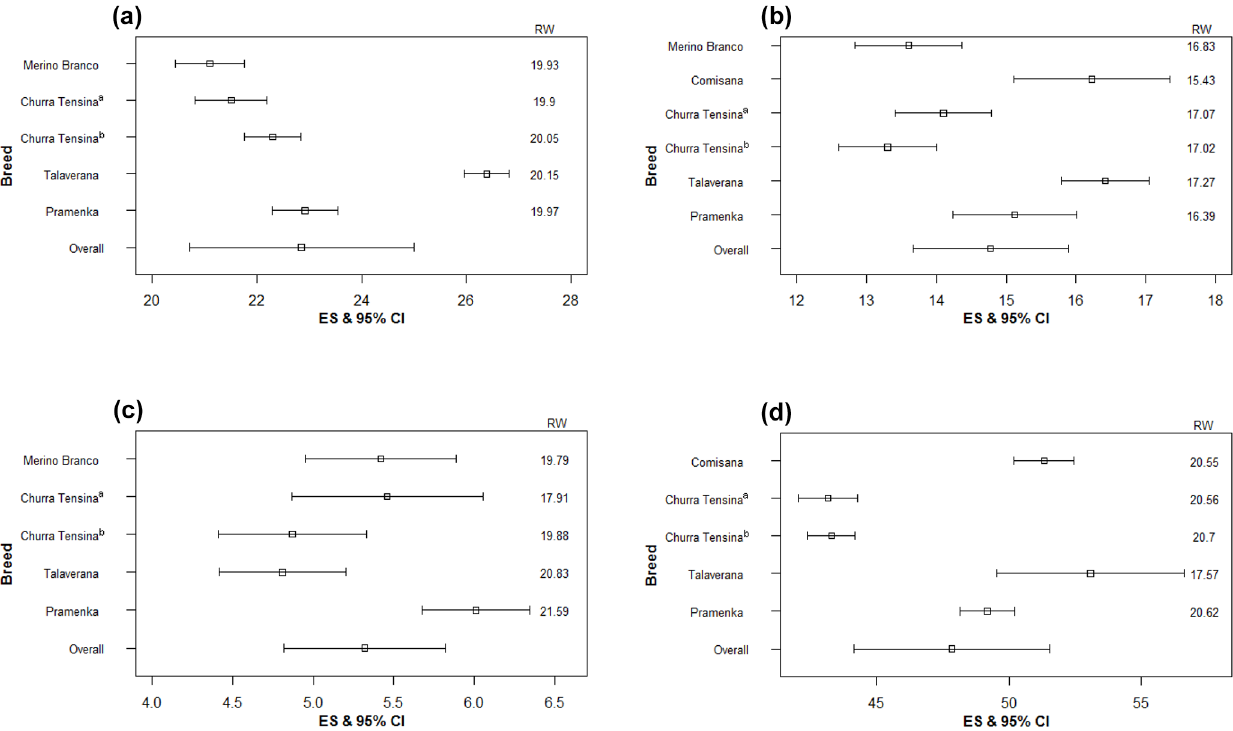
Figure 1. Meta-analysis of C16:0 (a) , C18:0 (b) , C14:0 (c) and SFA (d) . Different superscript letters ( a,b ) indicate lambs of the same breed included in different studies; CI: confidence interval; RW: relative weight of the study; Overall: overall pooled result.